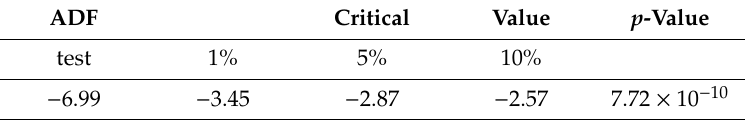
Table 4. The white noise test results of the water consumption data difference at monitoring point 1.